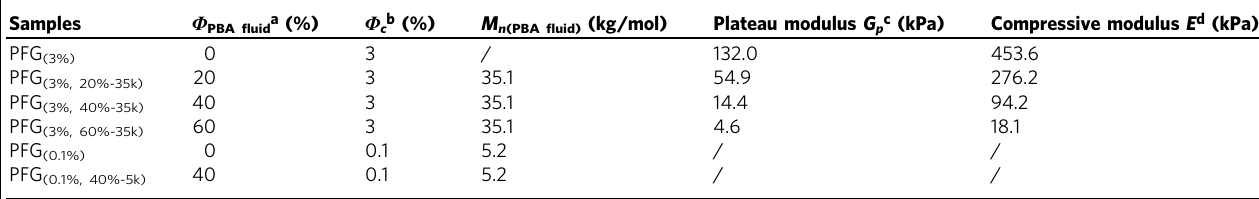
Table 1 Molecular parameters and mechanical characteristics of